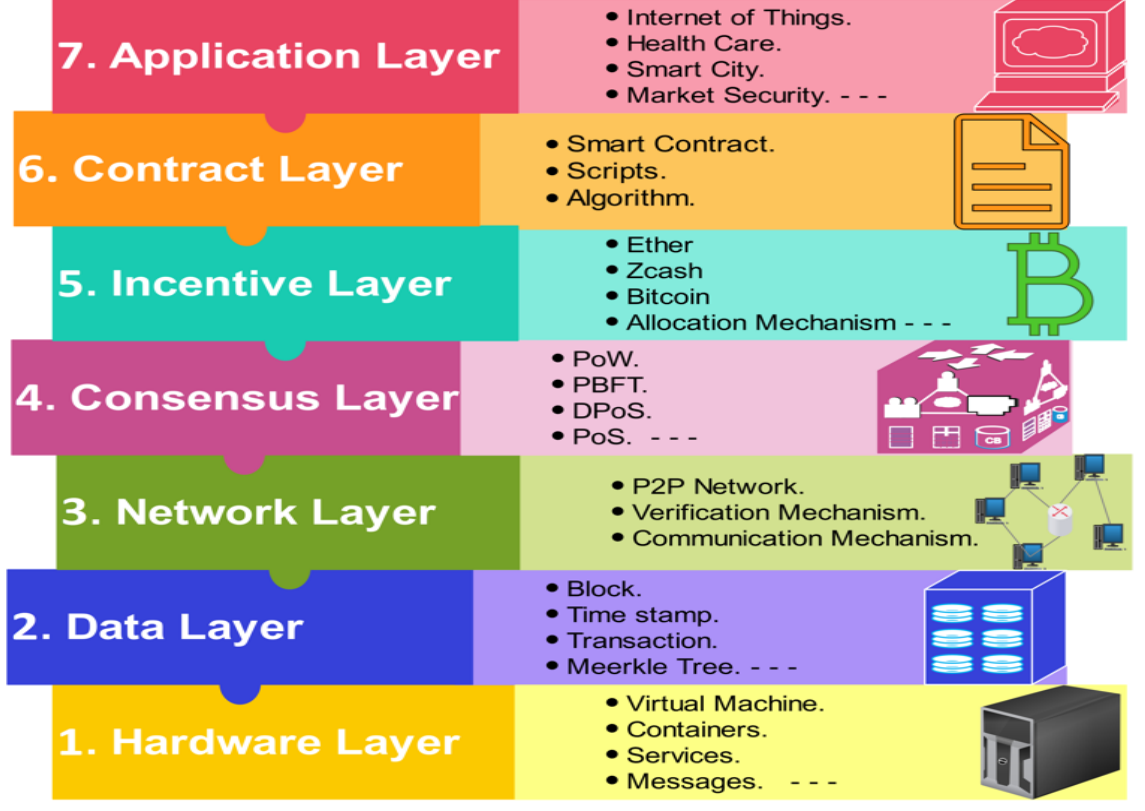
Figure 1. BC layered architecture.